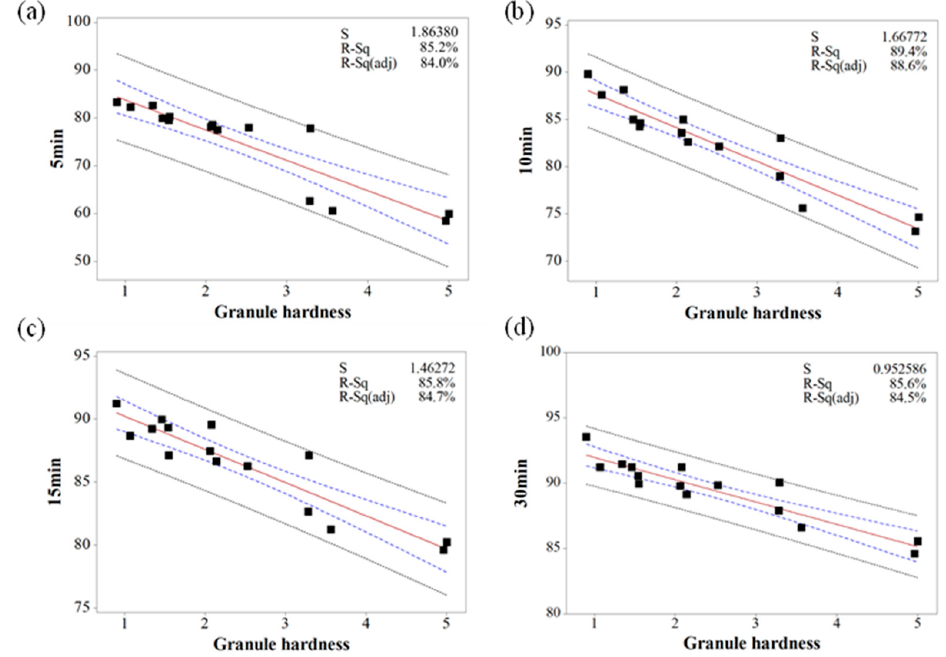
Figure 10. The fitted line plots of % dissolution (( a ) 5 min, ( b ) 10 min, ( c ) 15 min, and ( d ) 30 min) versus granule hardness. The black dots, red line, blue dotted line, and black dotted line represent the experimental results, best fitted regression, 95% confidence intervals, and 95% prediction intervals, respectively.